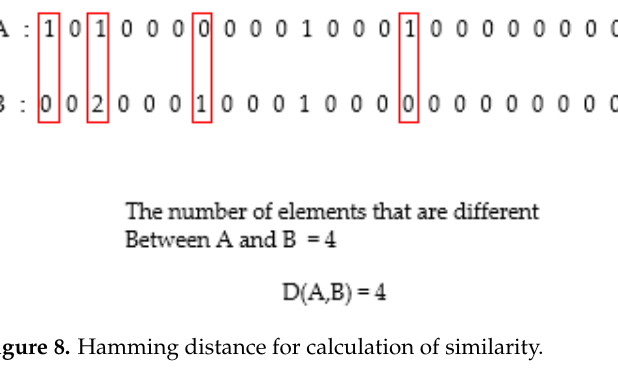
Figure 7. Example of input data: ( a ) a combined navigation situation consisting of navigation situations corresponding to features 1, 3, 11, and 15, and an example of conversion to a row vector, ( b ) a combined navigation situation consisting of navigation situations corresponding to features 3, 7, and 11, and an example of conversion to a row vector.